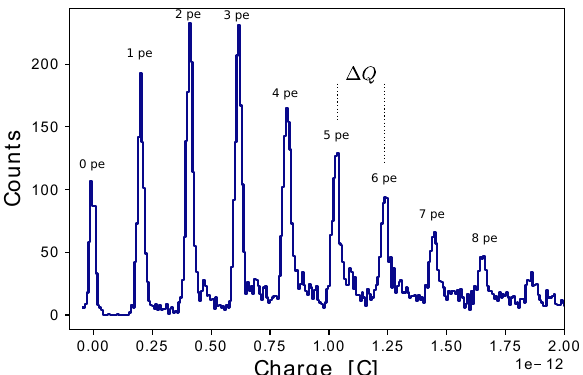
Figure 5. Charge spectrum of the SiPM operating at 56V/25 ◦ C. The first peak is the pedestal and the following represent the photoelectron equivalents. The inter-peak charge ∆ Q determines the SiPM gain.